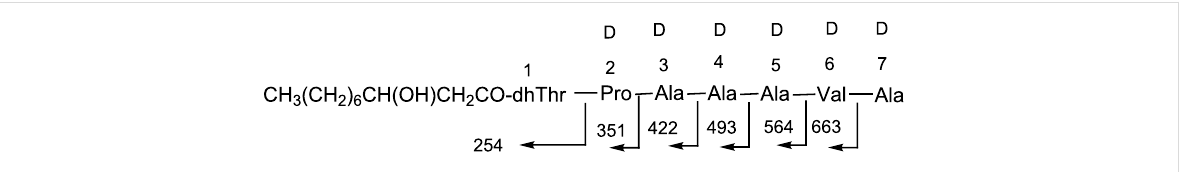
bond. This structural unit (Figure 3) was further confirmed by the m / z 254 ion in the FABMS spectrum of natural cichorino- toxin (Figure 1). We then determined the presence of three dhThr residues in the cichorinotoxin (Figure 6) by analyzing the NMR data; the β C H protons (olefinic protons) of the three dhThr moieties are found at δ H 6.37 (q, J = 7.0 Hz), δ H 6.24 (q, J = 7.0 Hz) and δ H 5.89 (q, J = 7.0 Hz) in the 1 H NMR spec- trum of the monoacetate (Supporting Information File 1, Figure S7). In the NMR spectra of the monoacetate, α H ( δ H 4.31) of Pro 2 showed a clear HMBC cross peak with the carbonyl car- bon ( C O, δ c 168.8, s) of dhThr 1 , indicating that Pro is the 2nd amino acid residue, as shown in Figure 3. The